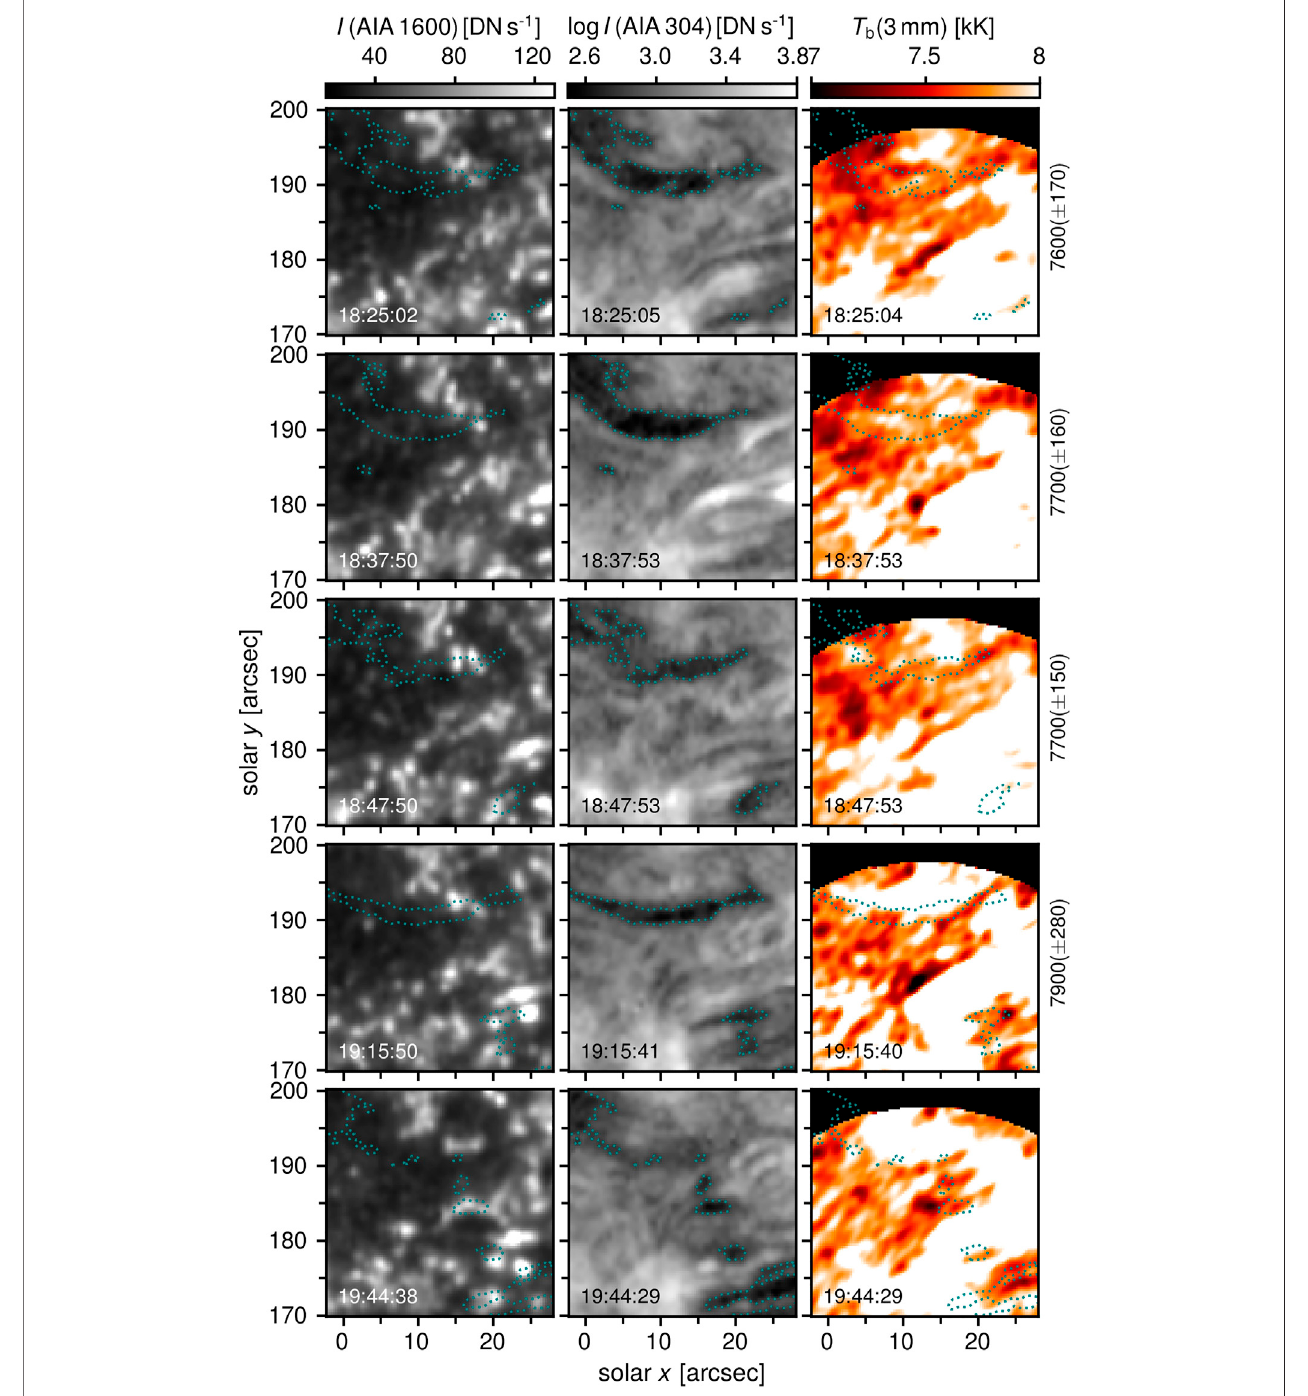
FIGURE4| AIAandALMABand3observationsatalatertimeon13April2019.TheBand3colormaprangeiscappedat8 kKtoenhancesmall T b variationswithin the fi lament. Images in the AIA 1600 Å passband are displayed for context. The cyan contours delimit the fi lament structure in the AIA304 Å images. The values on the right indicate the mean (±standard deviation) T b (3 mm) within the fi